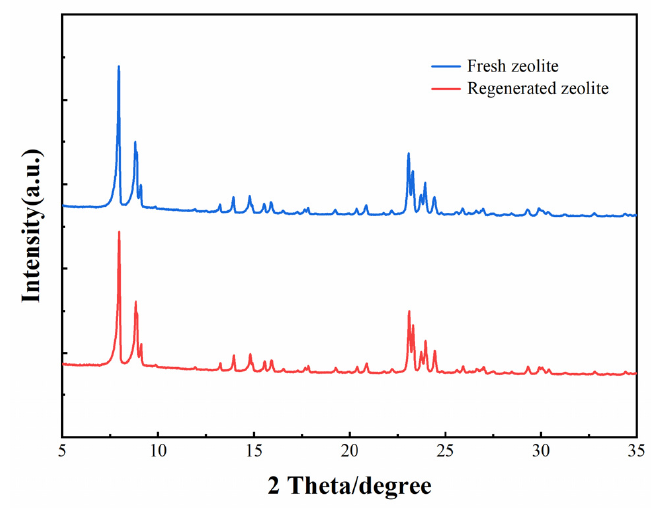
Figure 13. XRD pattern of fresh and regenerated HZSM-5 zeolite.